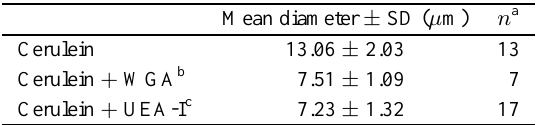
Morphometric estimated diameter of acinar injury vacuoles ( (cid:22) m) after cerulein pancreatitis, with or without simultane-